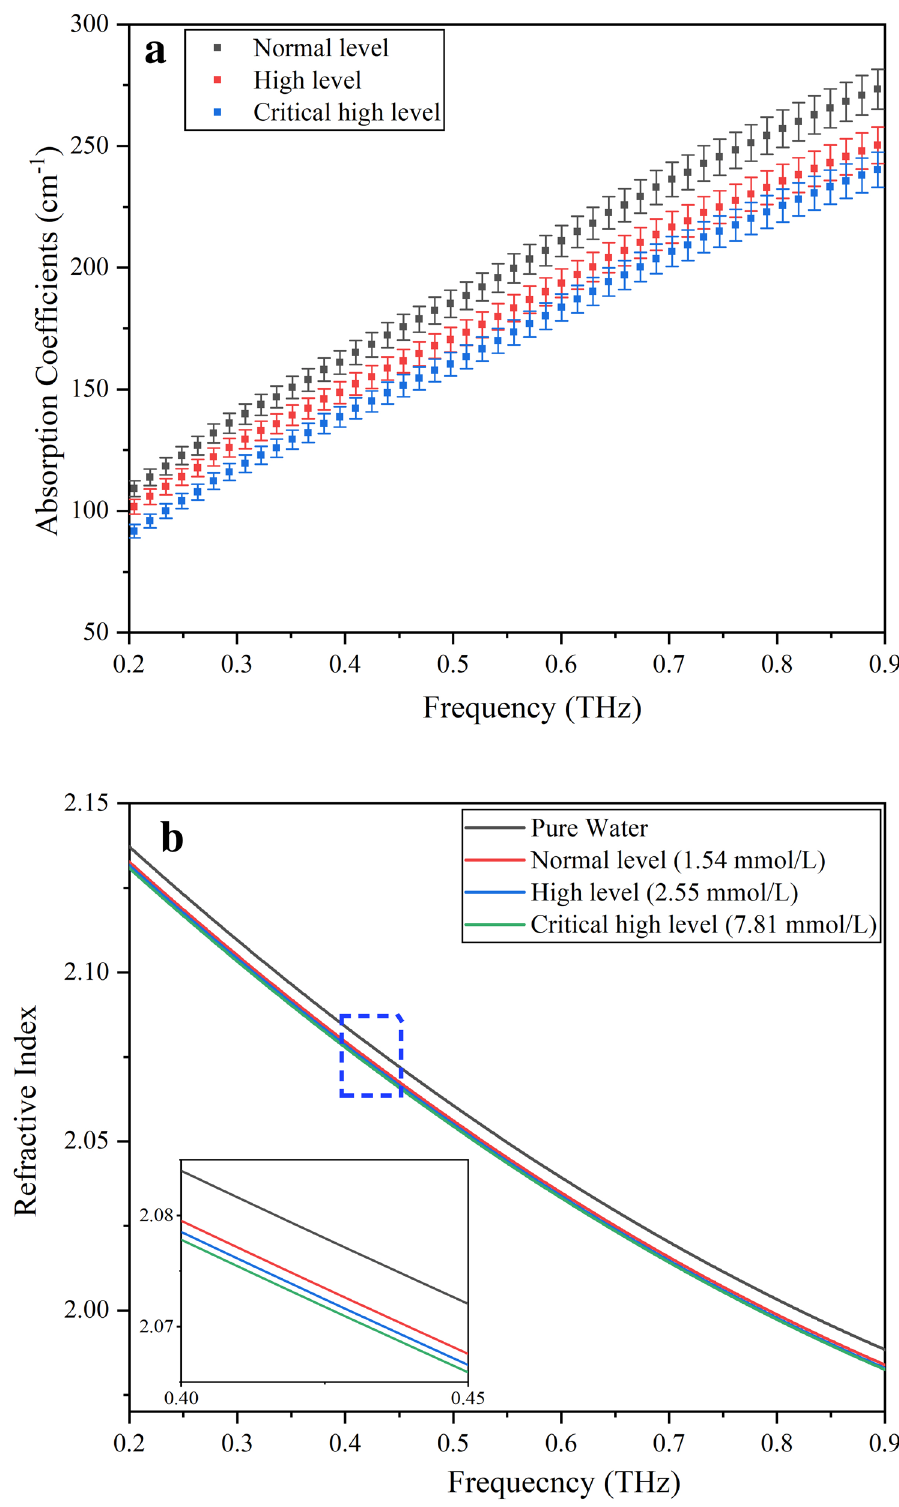
Figure 3. ( a ) THz absorption coefficient spectra of three groups of blood samples (normal level: 10; high level: 38; critical high level: 55). The solid squares represent the mean, and the error bars represent the deviation of the mean. ( b ) Refractive index of water and 3 whole blood